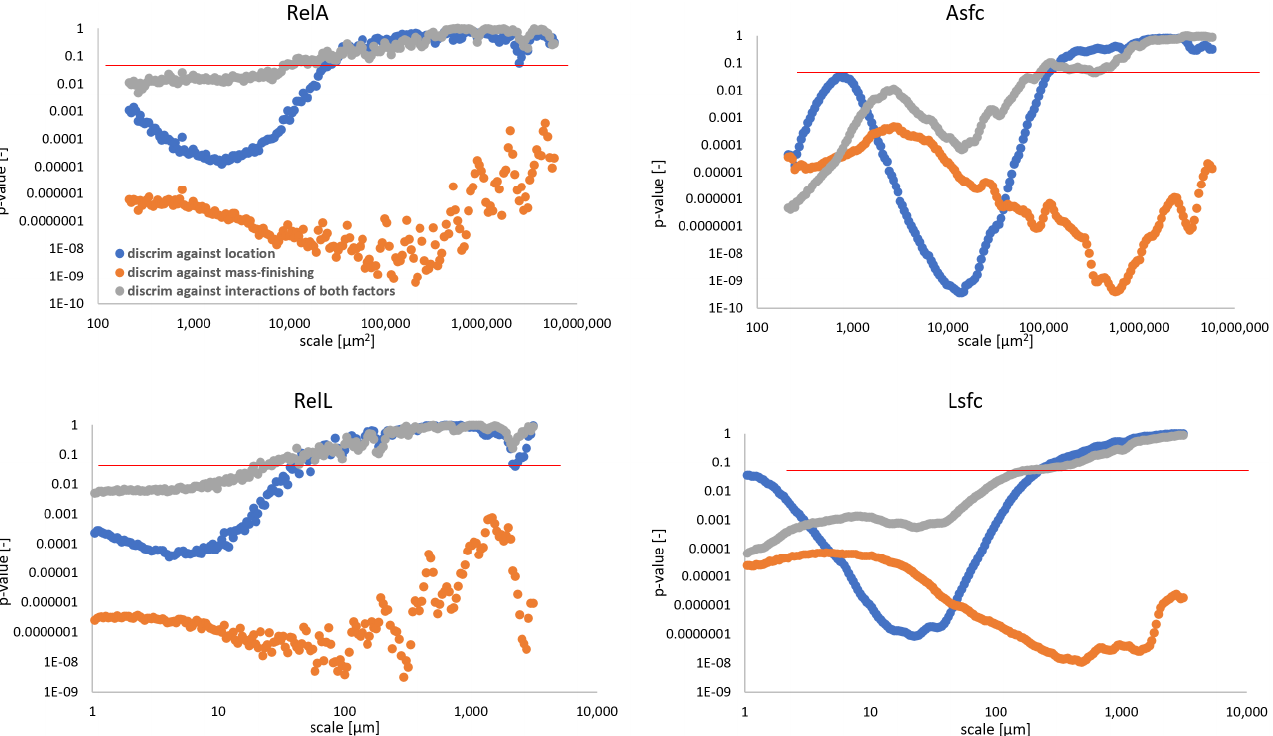
Figure 11. Evolution of p -value calculated in the discrimination analysis of two independent formation factors and their product as a function of scale for area- and length-scale parameters: RelA ( top left ), Asfc ( top right ), RelL ( bottom left ), Lsfc ( bottom right ). Please note that red line indicates p = 0.05 at each graph.